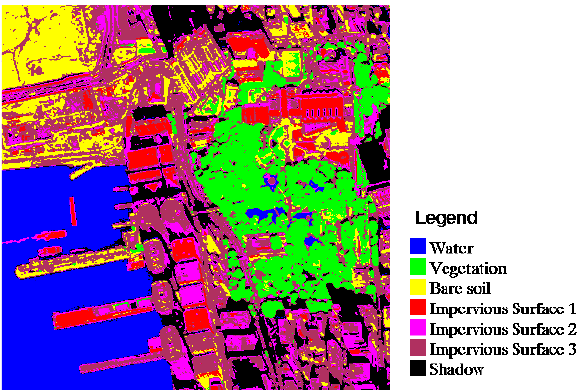
Fig. 9. Classification result with SVM classifier.